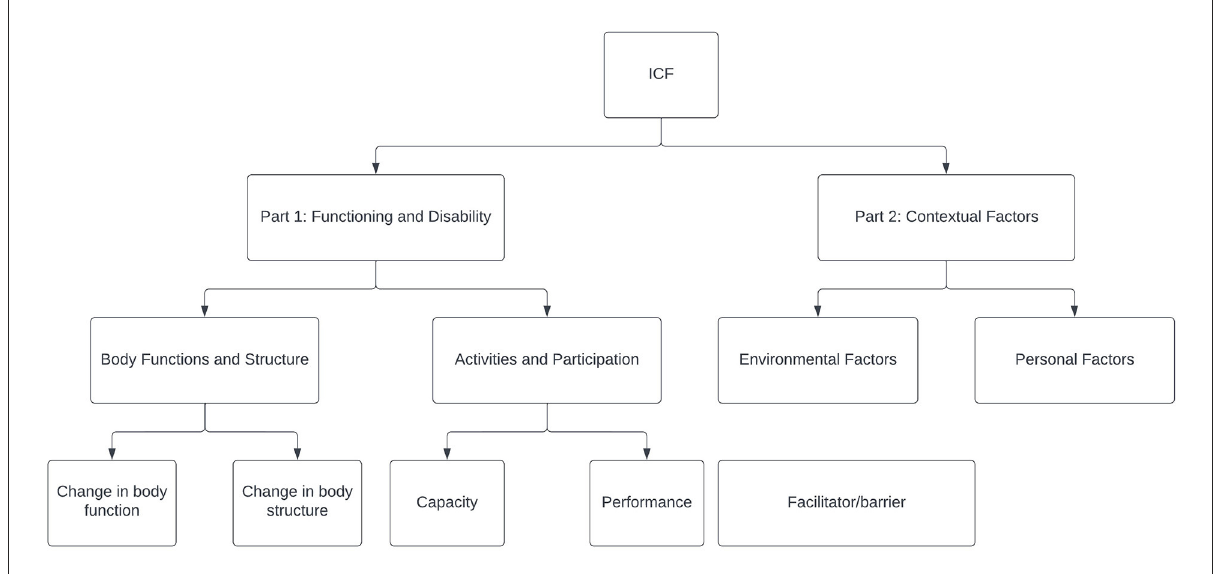
FIGURE1 The International Classification of Functioning, Disability, and Health (ICF) framework (20).